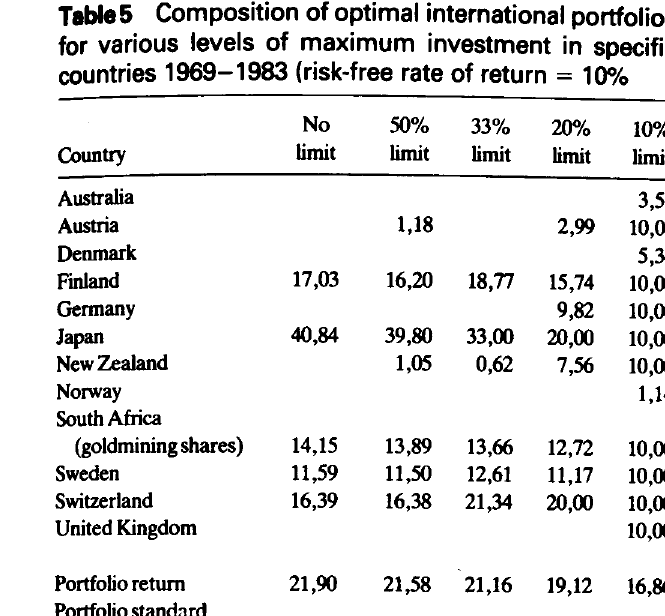
Table5 Composition of optimal international portfolios for various levels of maximum investment in specific countries 1969-1983 (risk-free rate of return = 10% Country